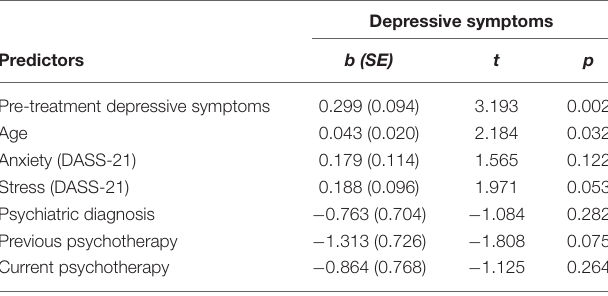
TABLE 3 | Predictors of the post-treatment depressive symptoms (multiple regression).